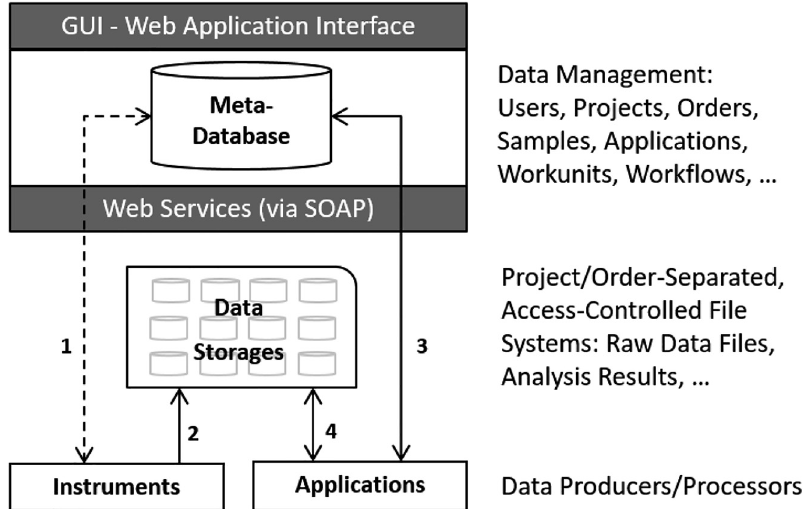
Figure 4: Rough sketch of system